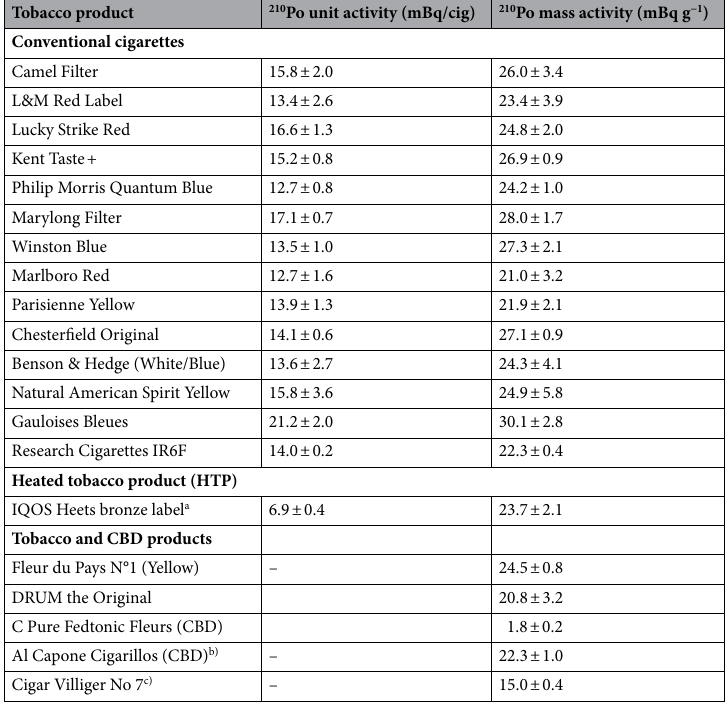
Table 1. 210 Po activity (mBq per cigarette and mBq g −1 tobacco, n = 5) in the tobacco fillers of cigarettes and in mixed tobacco and CBD products sold in Switzerland. The given values are an average of five replicates per tobacco products, each replicate came from the same pack bought in a local tobacco shop (Lausanne, Switzerland). a IQOS Heets cigarette contains on average 290 mg of tobacco compared to 600 mg for conventional cigarettes. b A cigarillos Al Capone CBD (a mixture of tobacco and CBD) weighs on